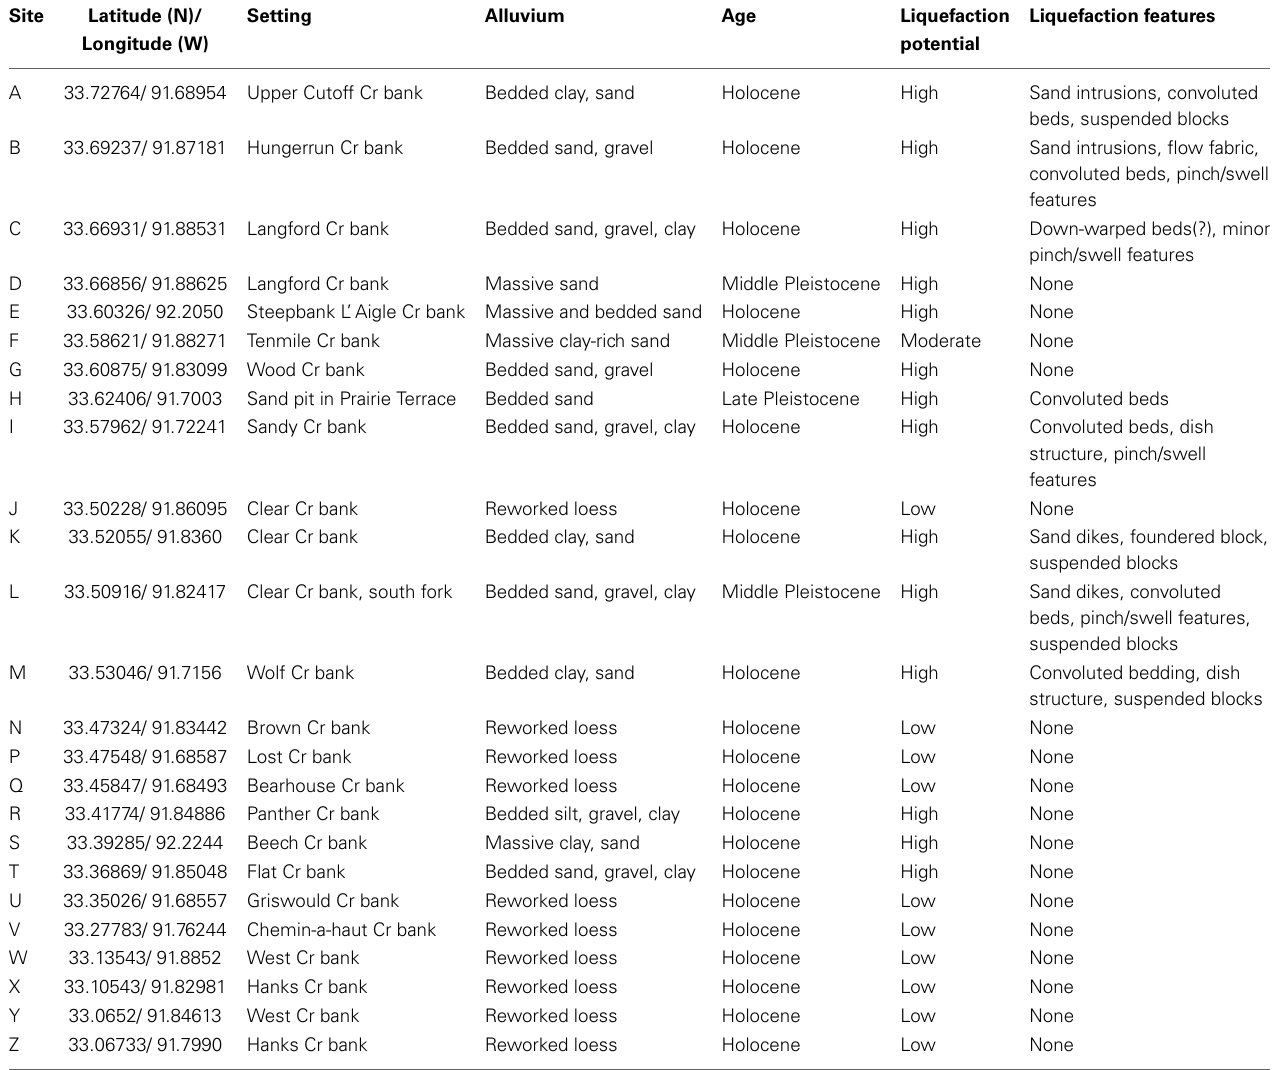
Table 1 | Field site